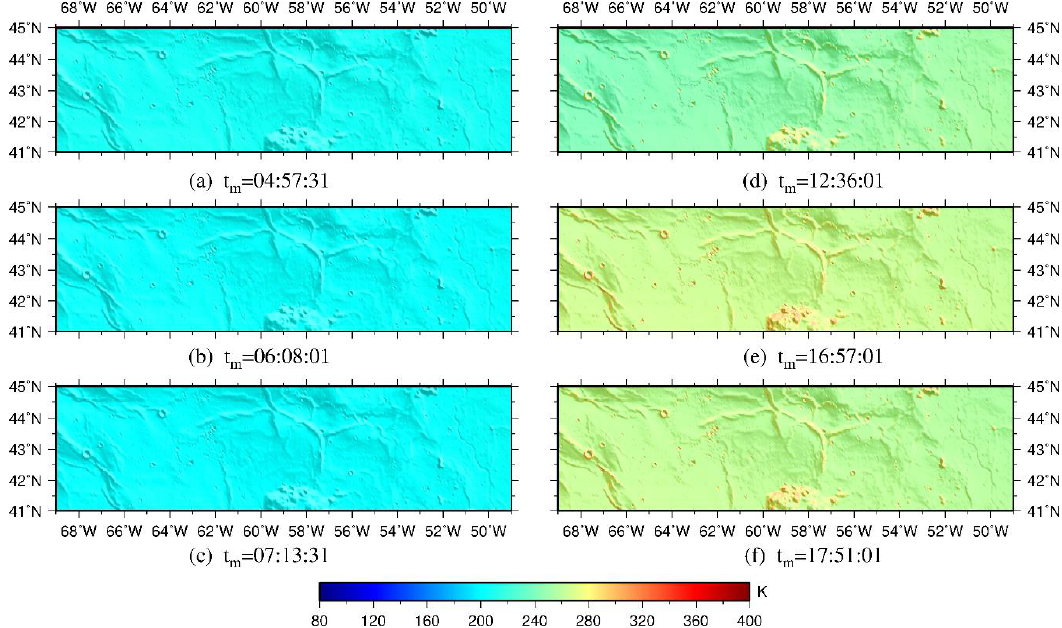
ff erent time at the depth of − 0.0656